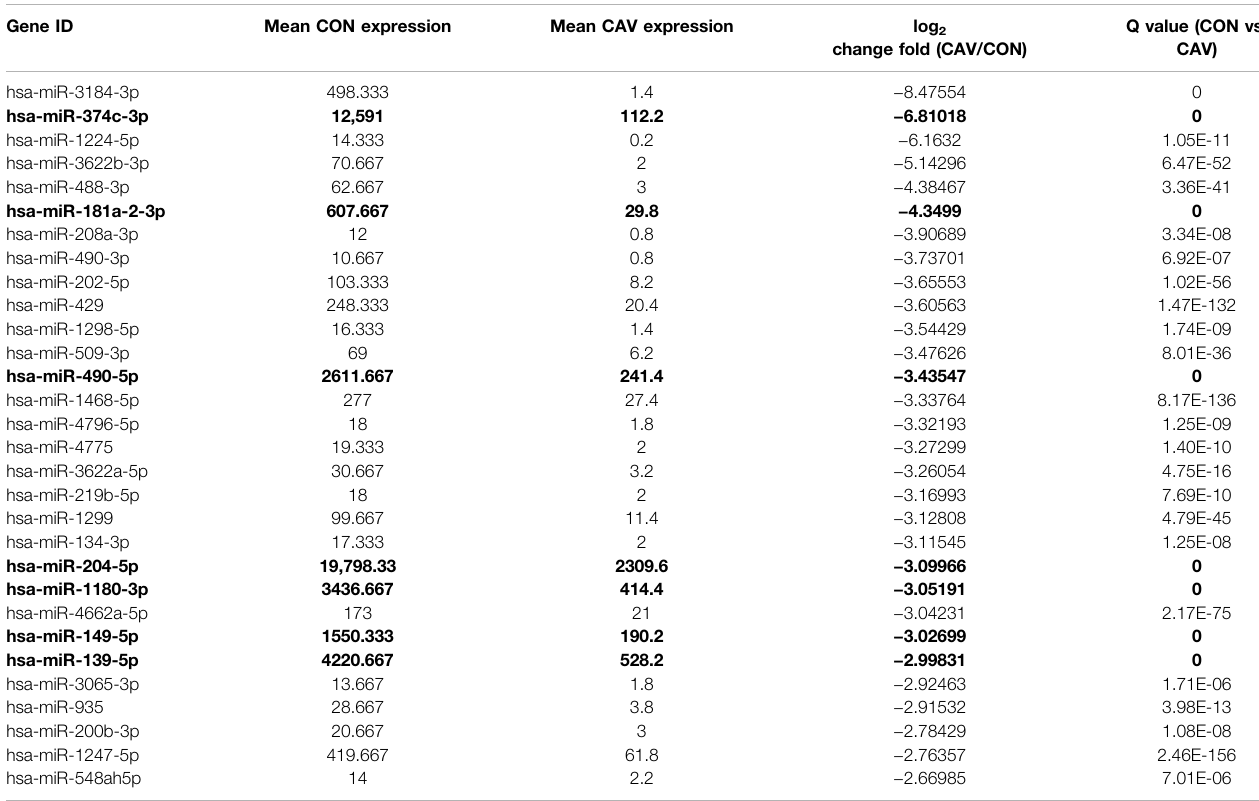
Ranked by log 2 change fold; Bold: FKPM > 500 in normal valves (CON).